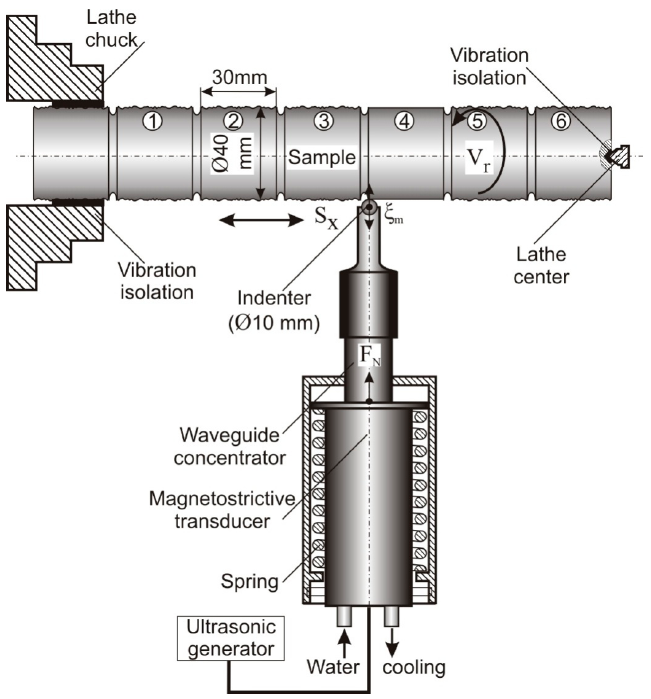
Figure 3. Ultrasonic treatment